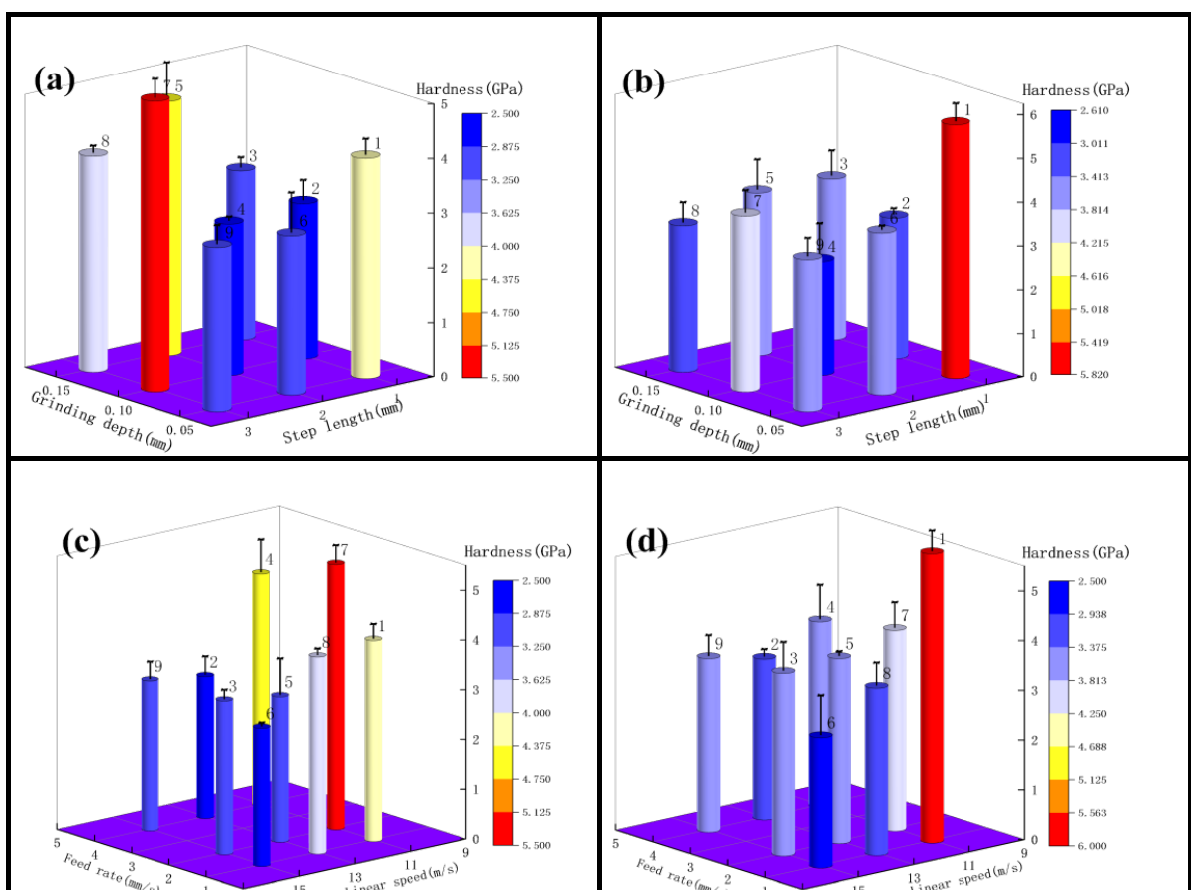
Figure 11. ( a ) For test 2, the variables are grinding depth and step length; ( b ) for test 4, the variables are grinding depth and step length; ( c ) for test 2, the variables are linear speed and feed rate; ( d ) for test 4, the variables are linear speed and feed rate.